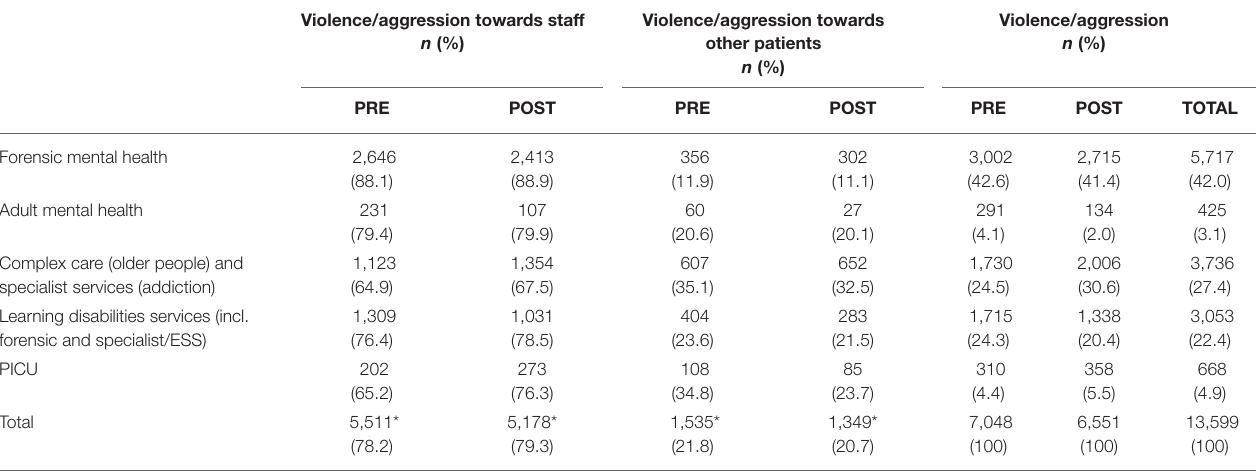
TABLE 2 | Incidents of violence/aggression pre- and post-intervention by type of service/ward.